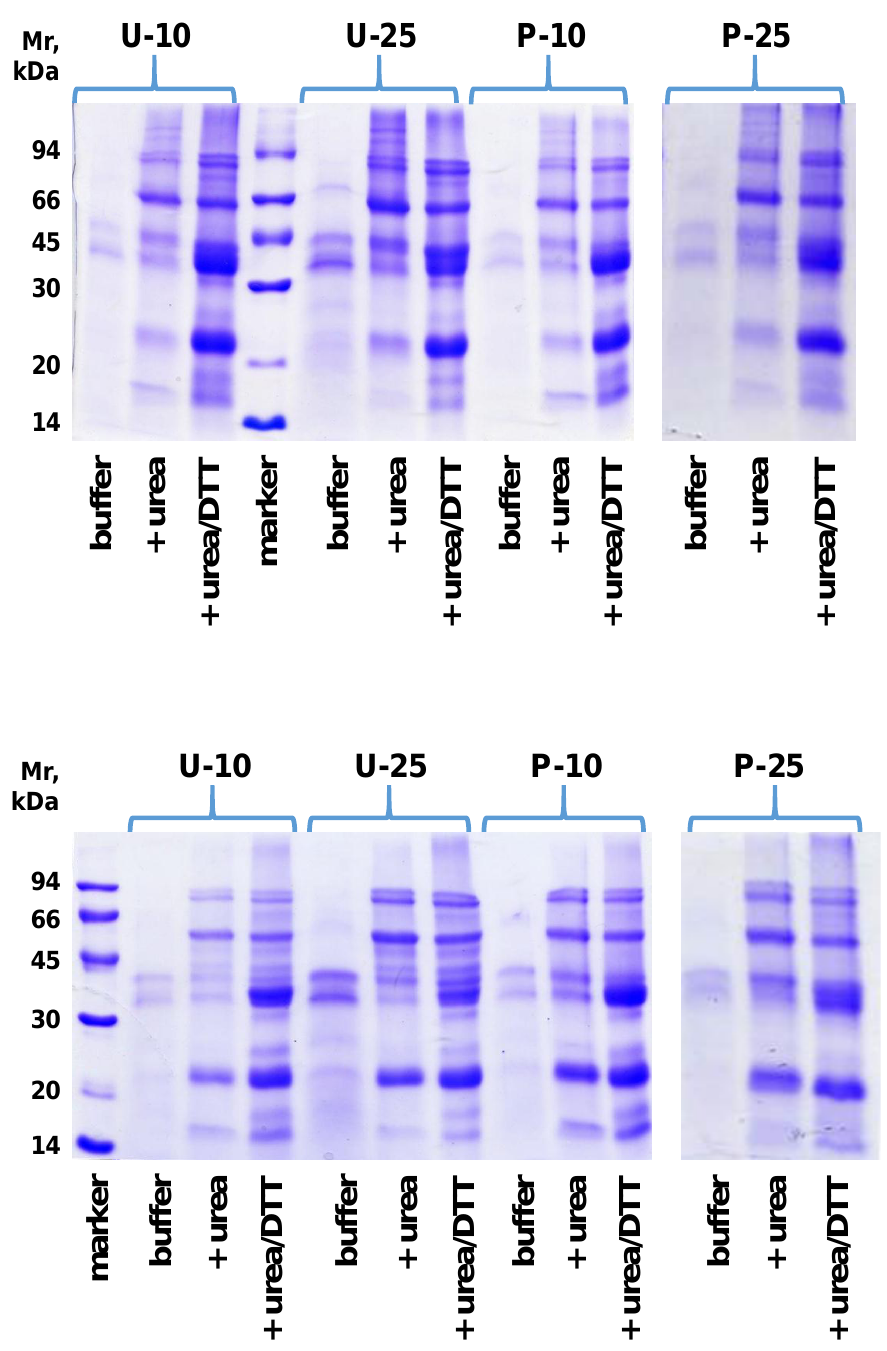
Figure 2. SDS-PAGE profile of proteins solubilized from the various samples in different buffer systems. Aliquots of the various samples were suspended under stirring in 0.05 M sodium phosphate, 0.1 M NaCl, pH 7.0, in the presence/absence of 6 M urea and 10 mM DTT, as indicated. Separations were run on protein samples denatured in the absence (top) or in the presence (bottom) of 2-mercaptoethanol. Samples are identified by letters (indicating the use of untreated (U) or parboiled (P) rice) and digits (10, 25) indicating the percent content in soybean flour. Thiol-disulfide exchange reactions are among the major contributors to the formation of a covalently-linked protein network in many foods, where disulfides represent the most “natural” type of inter-protein covalent bond [14]. In this frame, it may be pointed out that thiol-disulfide exchange